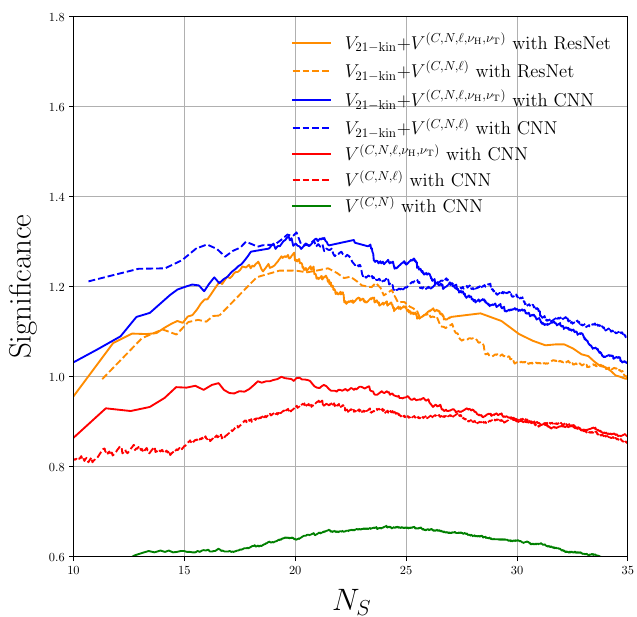
Figure 5 . Significance at the HL-LHC with L = 3 ab − 1 for CNNs and